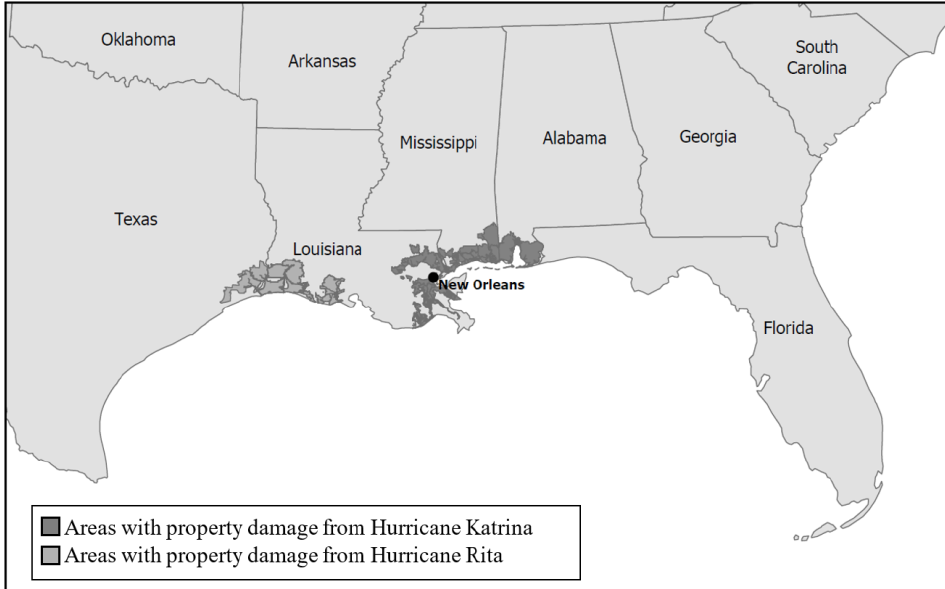
Figure 1. Areas damaged by Hurricanes Katrina and Rita.